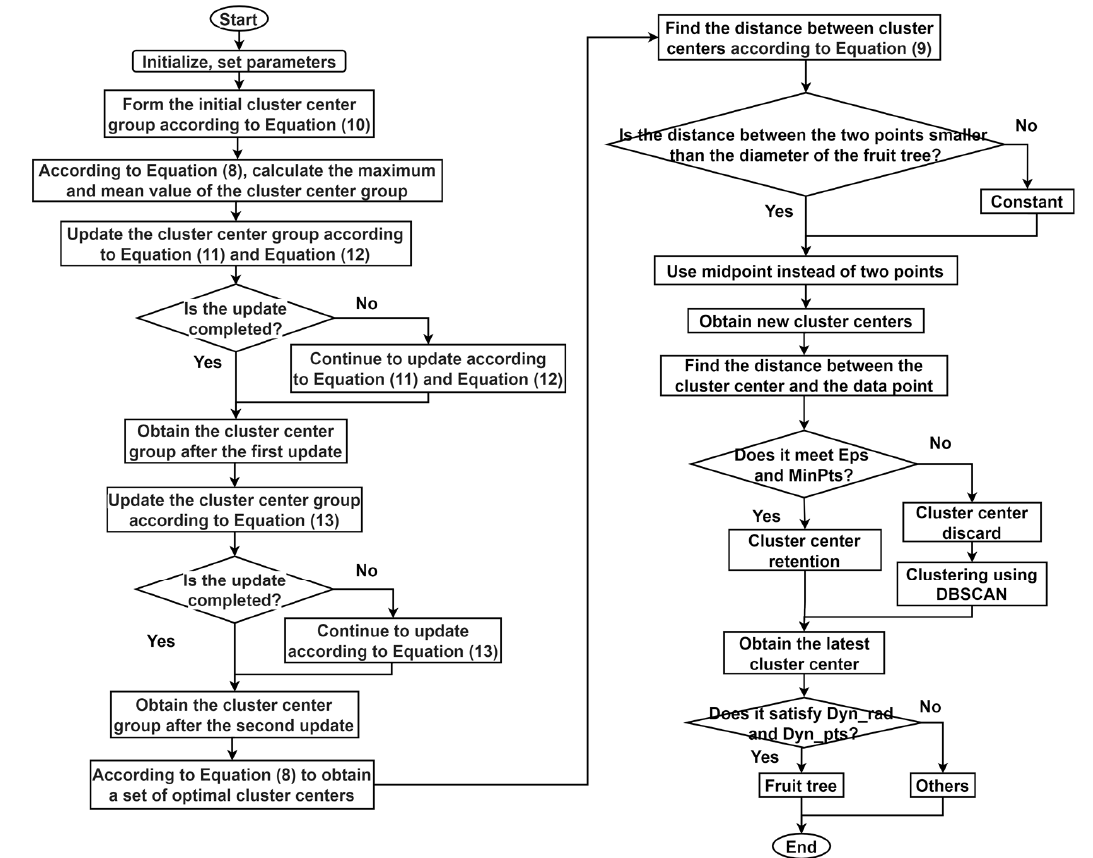
Figure 3. Fruit tree detection based on LAPO-DBSCAN.